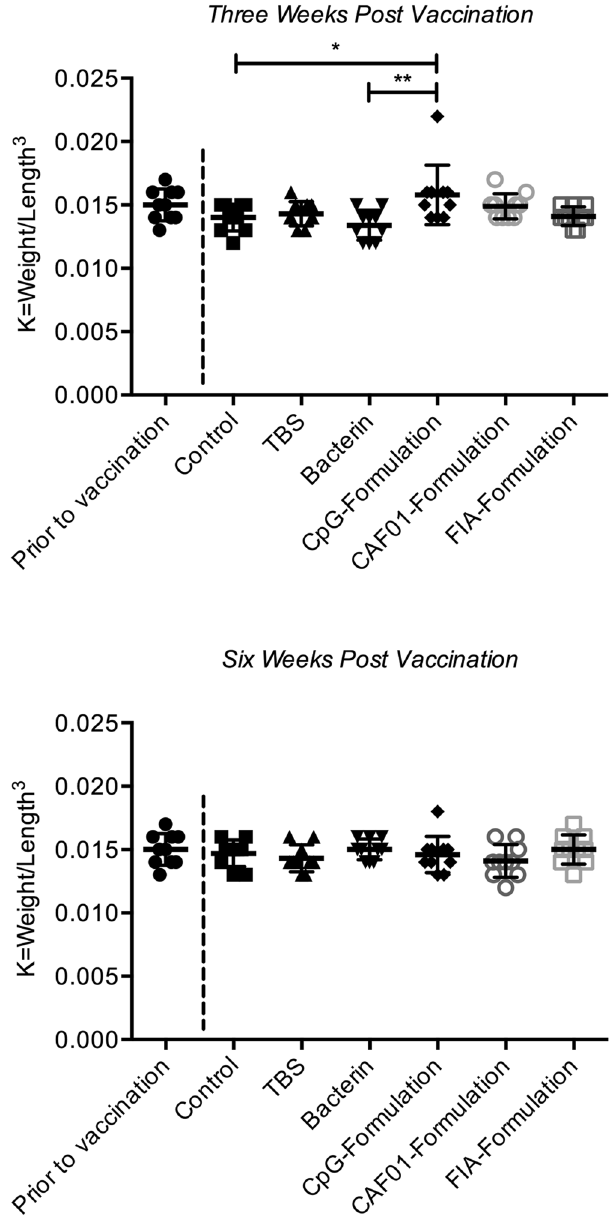
Figure 1. Fultons condition factor. Calculations and statistical methods are described in the materials and methods section. Values are presented as dot-plots with mean + / − standard deviation. Asterisks show statistically significant differences between groups and denote: * P < 0.05 and ** P < 0.01. Condition factors obtained prior to vaccination are only for reference purposes. These were not included in the statistical